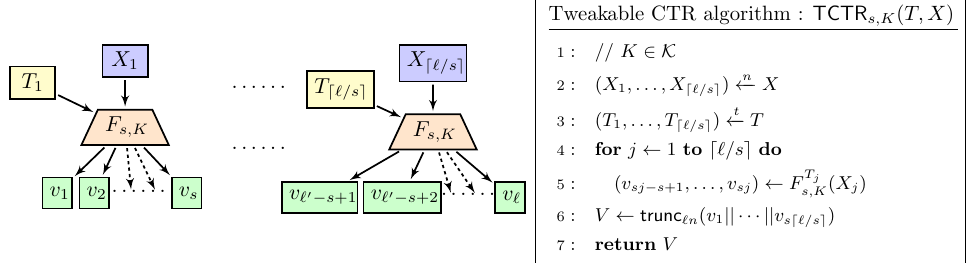
Figure 5: Tweakable CTR. This algorithm is parameterized by a multi-forkcipher F s : K × { 0 , 1 } t × { 0 , 1 } n → { 0 , 1 } sn . An input vector X = { X j | 1 ≤ j ≤ d ‘/s e} and a tweak vector T = { T j | 1 ≤ j ≤ d ‘/s e} must be provided to generate the output vector V having ‘ n -bit blocks. Here ‘ 0 is defined as s d ‘/s e